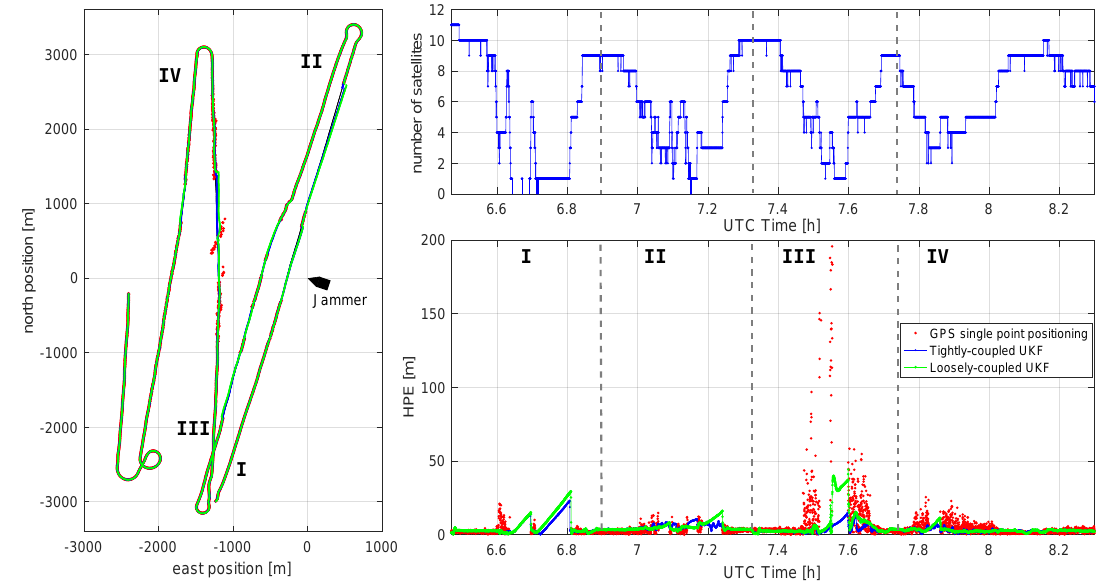
Figure 12. The performance of the hybrid IMU/GNSS/DVL system during the complete measurement scenario using the midship GPS antenna: overview ( left ); number of available satellites ( top right ); and the HPE ( bottom right